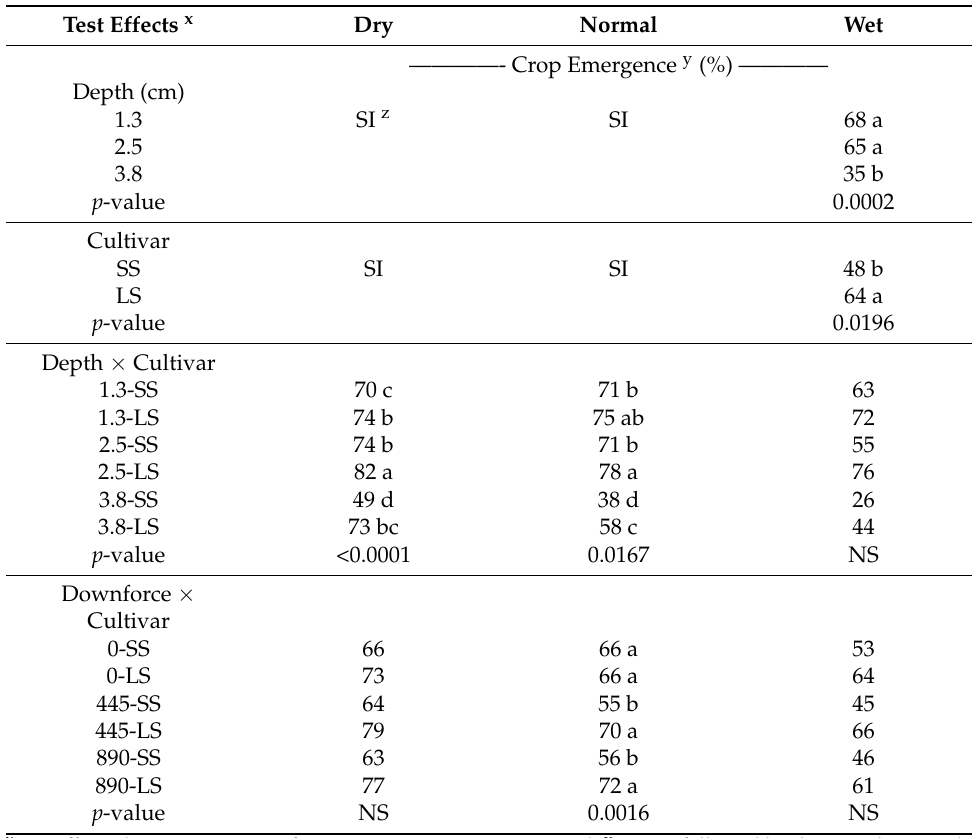
Table 6. Influence of seeding depth, cultivar, depth × cultivar, and downforce × cultivar on crop emergence in different at-plant field conditions in 2017.